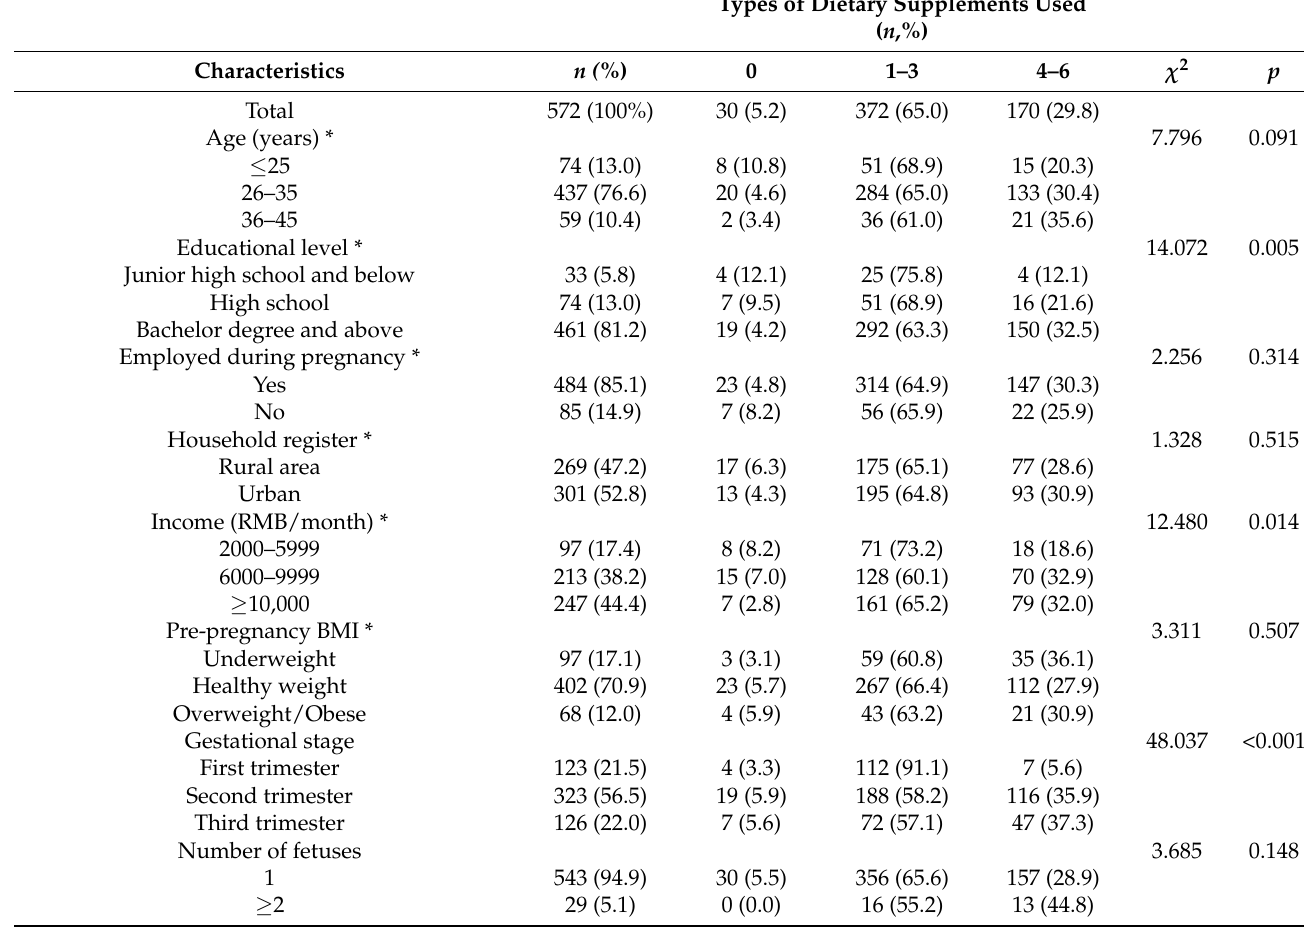
Table 1. Prevalence of dietary supplement use among pregnant women by demographic characteris- tics ( n =